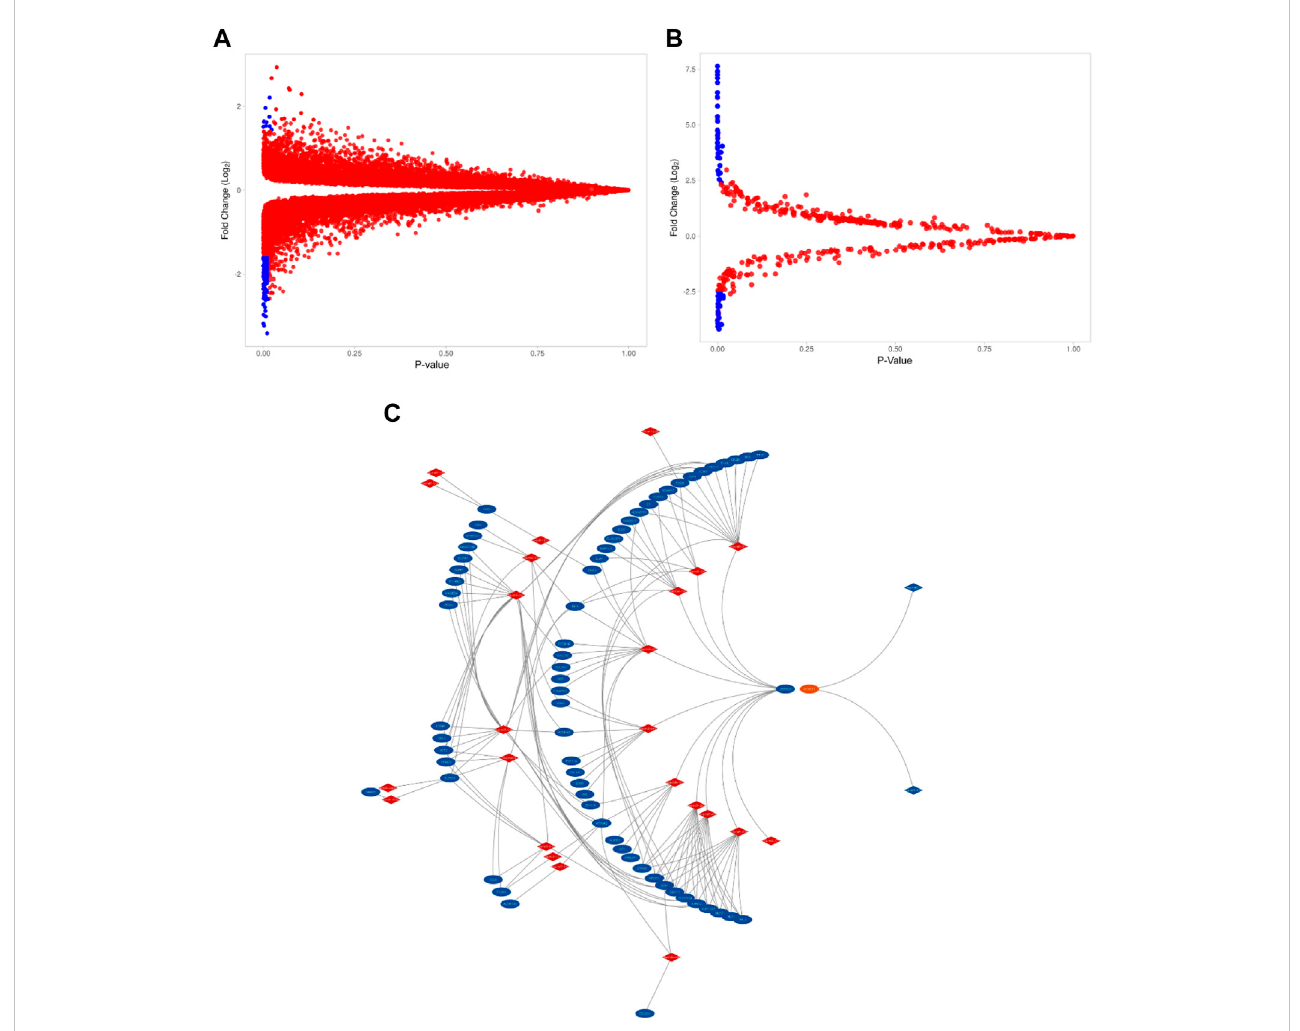
FIGURE 1 The expression level of DEGs and DEmiRNAs. (A) . Volcano plots of GSE115810 showing the DEGs as blue dots. (DEGs with FC > 2.5, p -value < 0.05) (B) . Volcano plots of GSE35794 showing the DEmi as blue dots (Demi with FC >> 2.5, p -value < 0.05). (C) . Differentially expressed miRNA (in red) and their target DEGs (in blue) interaction